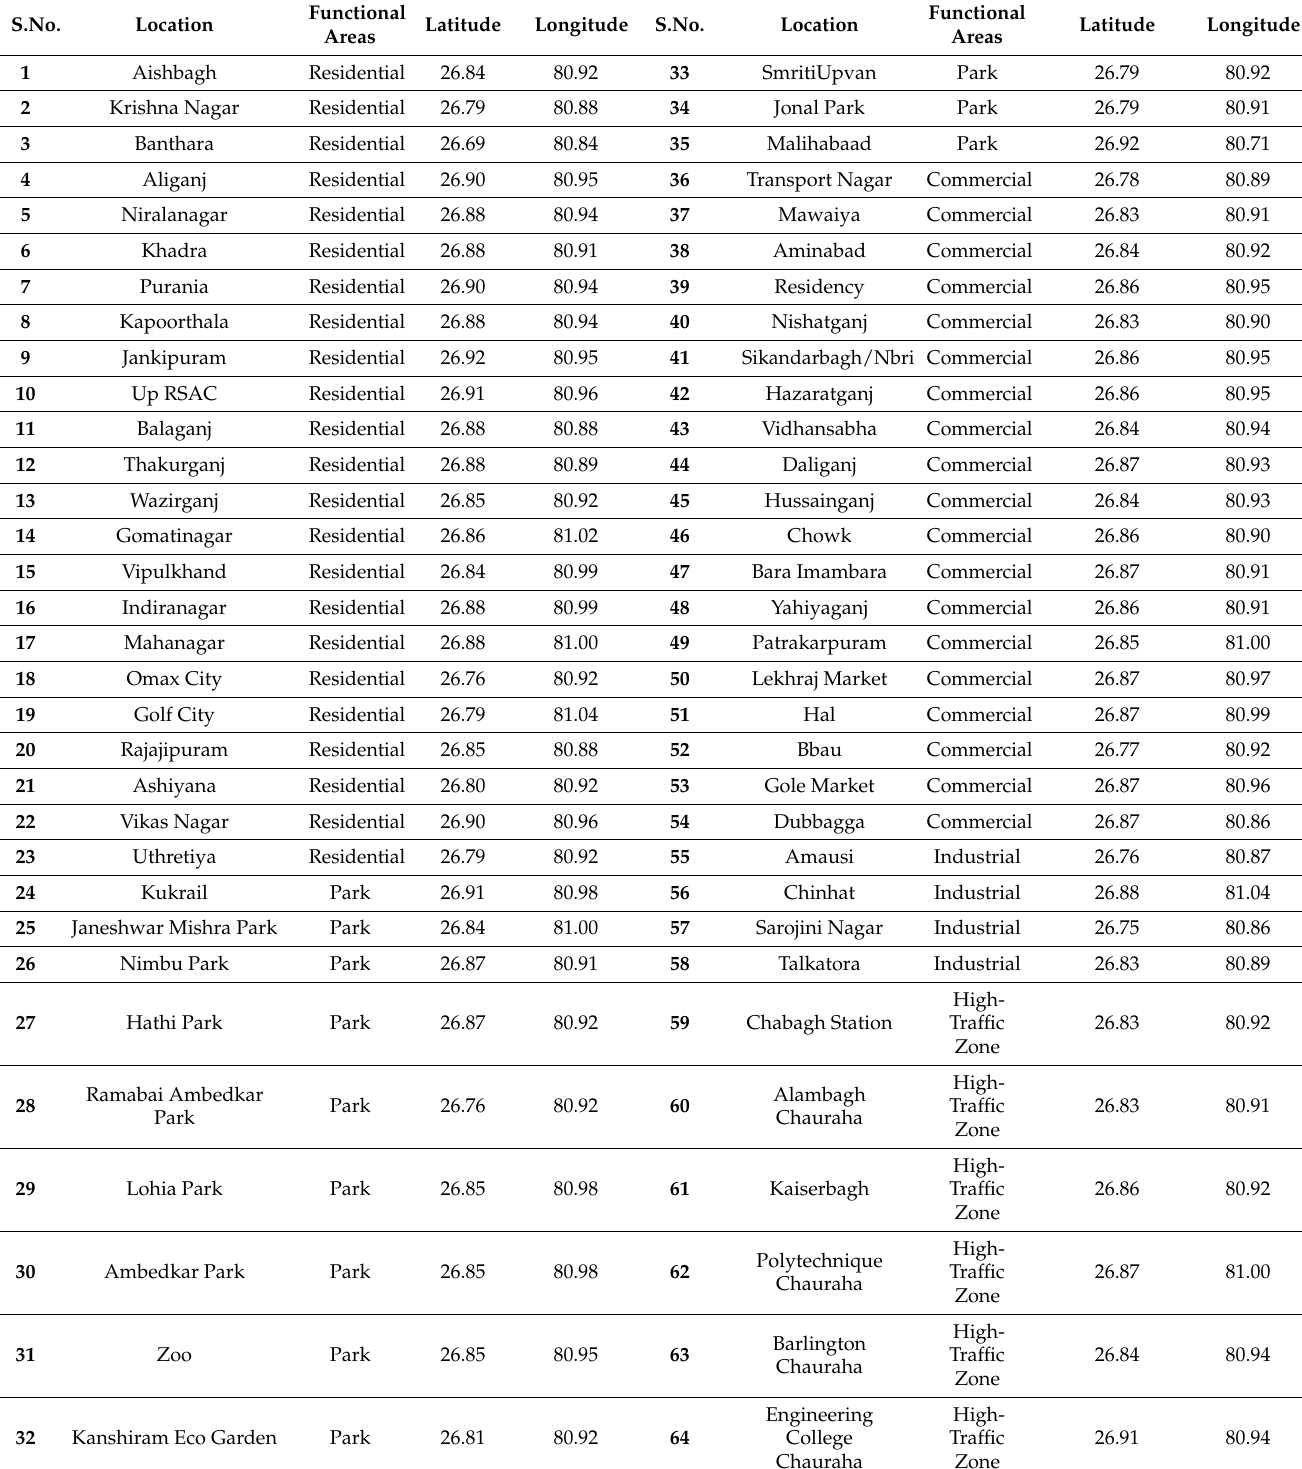
Table 1. Sampling locations representing five different functional areas (i.e., residential, commercial, high-traffic areas, parks, and industrial areas).